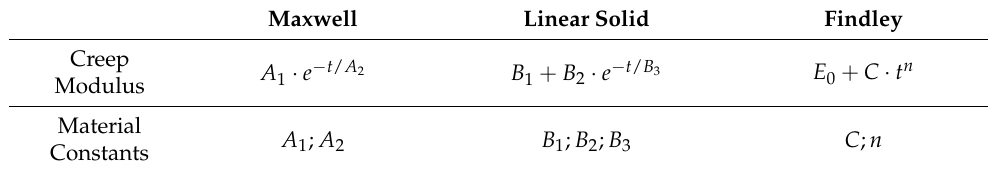
Table 3. Considered analytical models creep modulus expression and fitting constants.